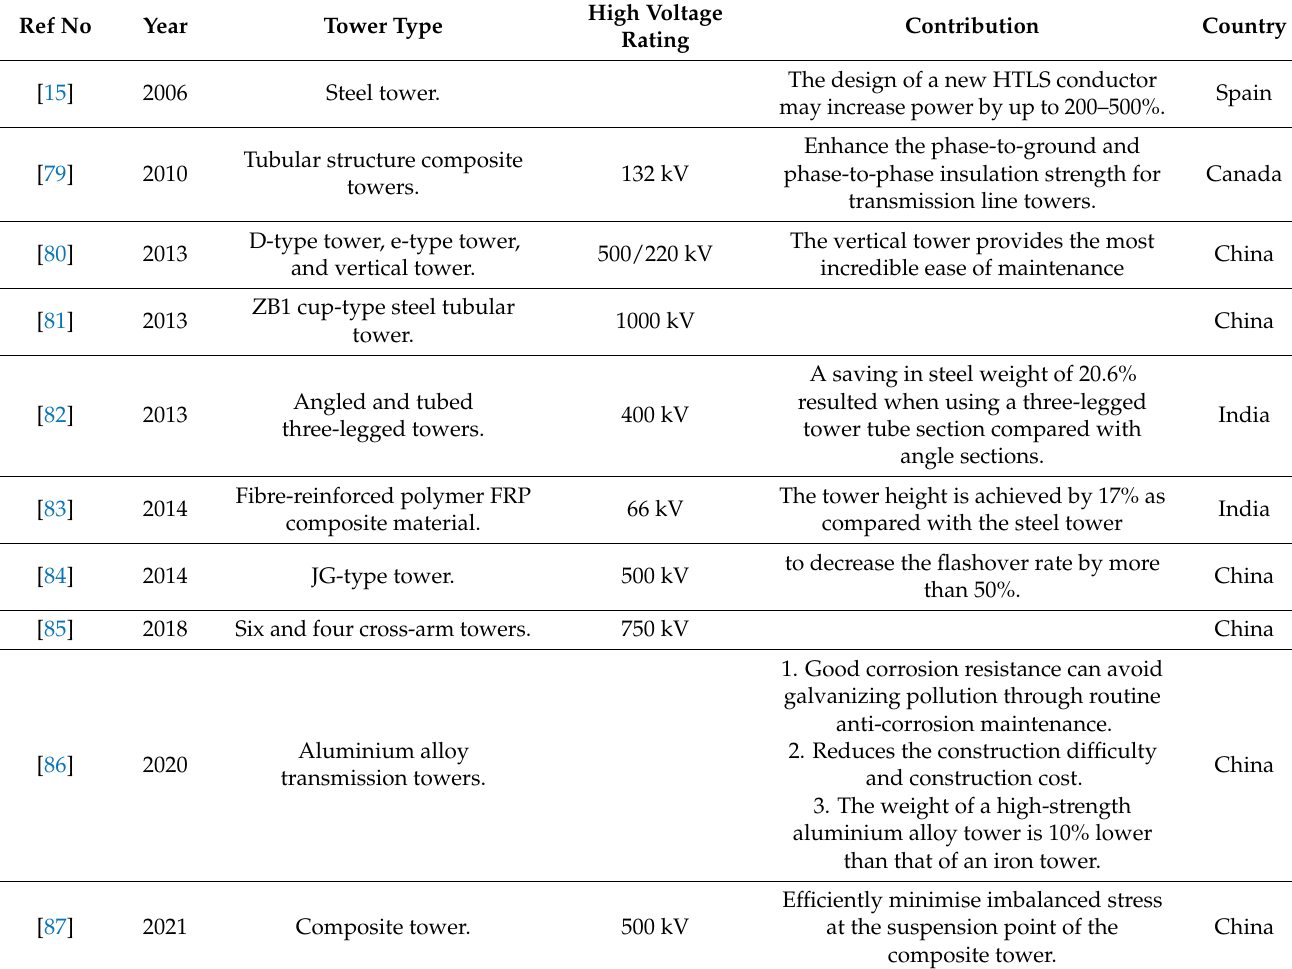
Table 3. History of Tower